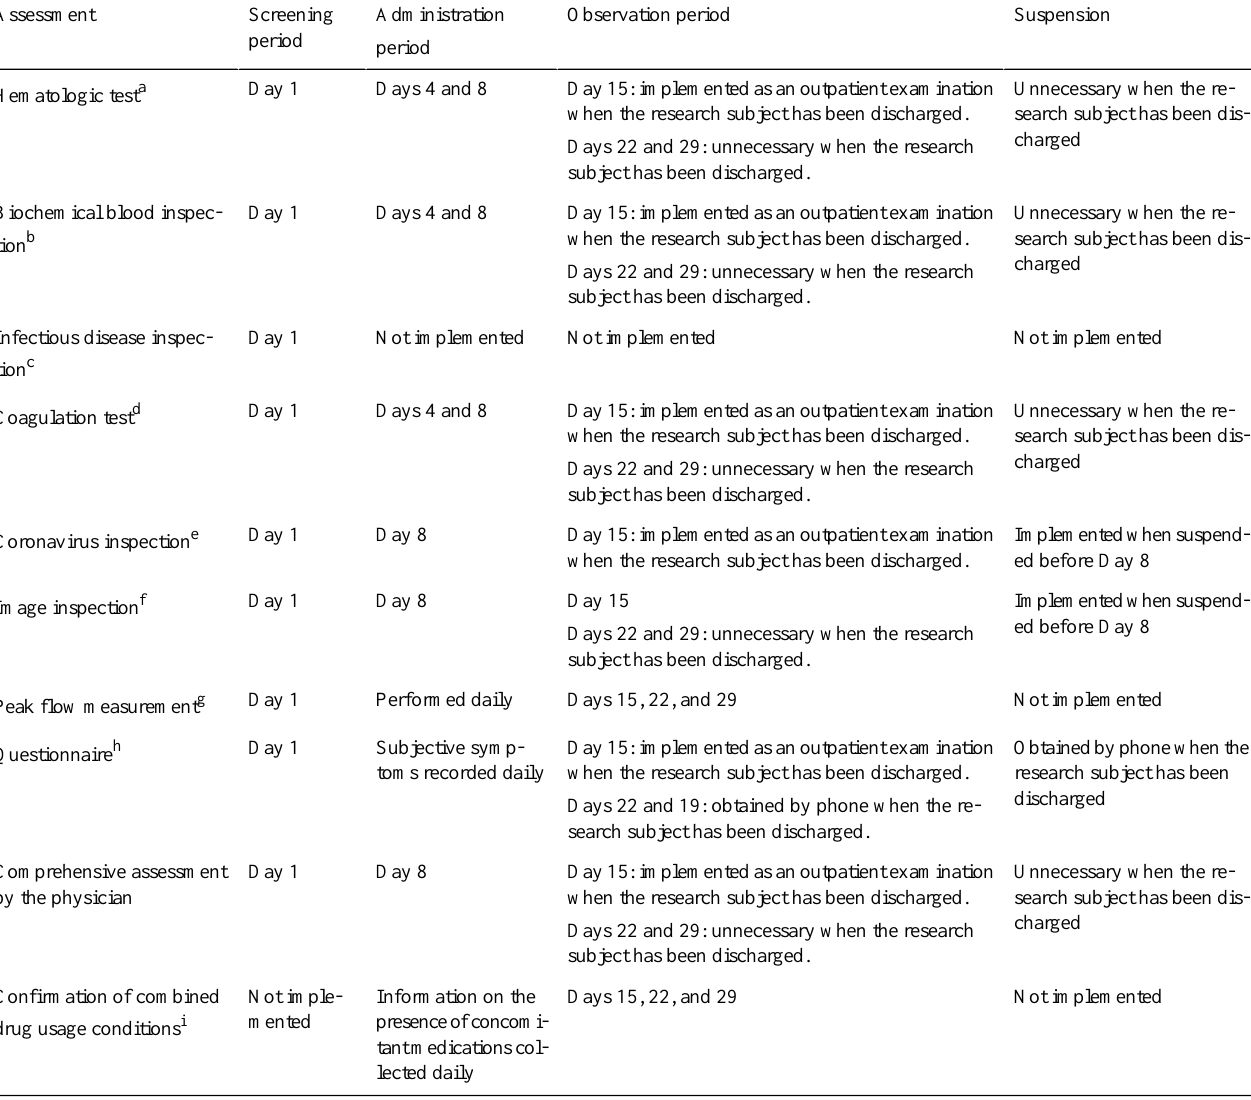
Table 1. Assessment details and days of